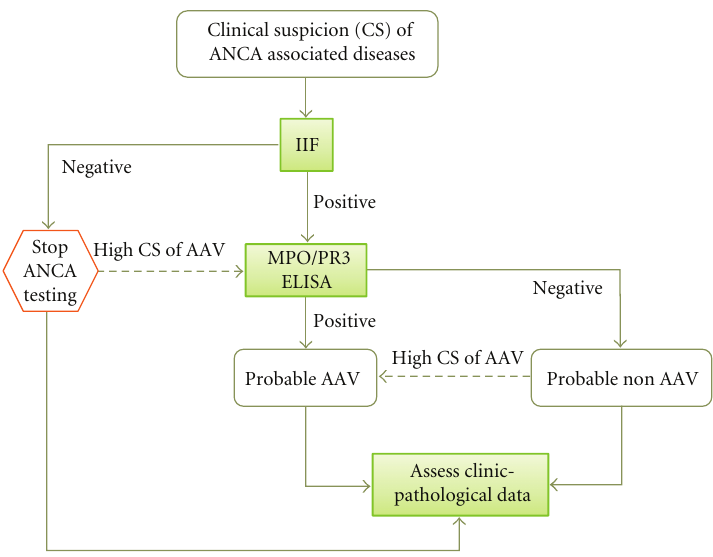
Figure 1: Algorithm on ANCA